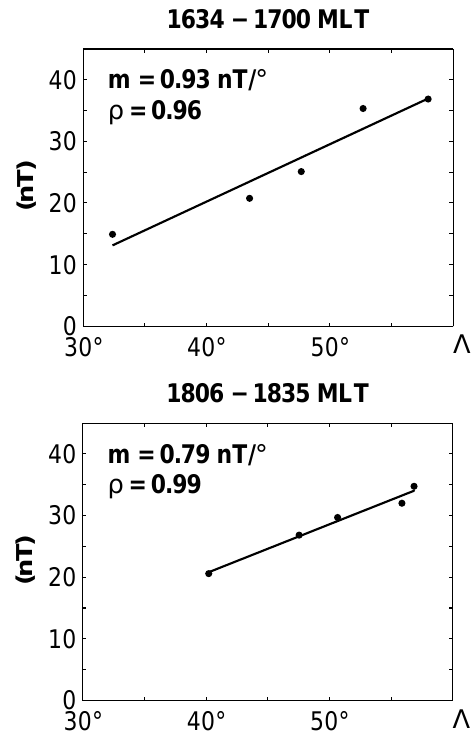
Fig. 10. The latitudinal variation of the asymptotic response along M1 in two narrow MLT strips in the dusk sector. m is the angular